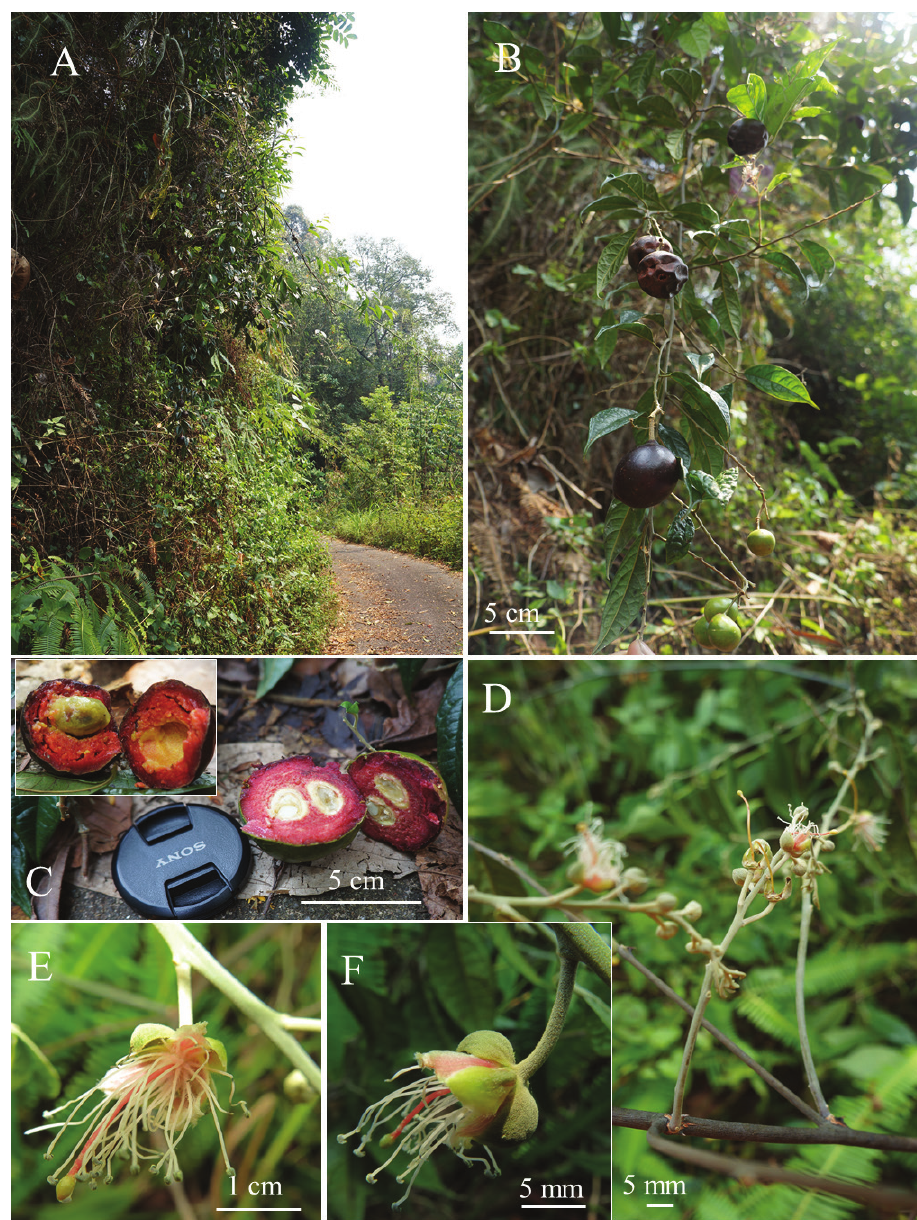
Figure 3. Capparis kenaboiensis Julius, sp. nov. A habitat B fruiting branch C cross-section of fruit (upper left, the cut ripe fruit) D inflorescence E flower, front view F flower, lateral-abaxial view. (Photographs A–D by A. Julius and E–F by K.